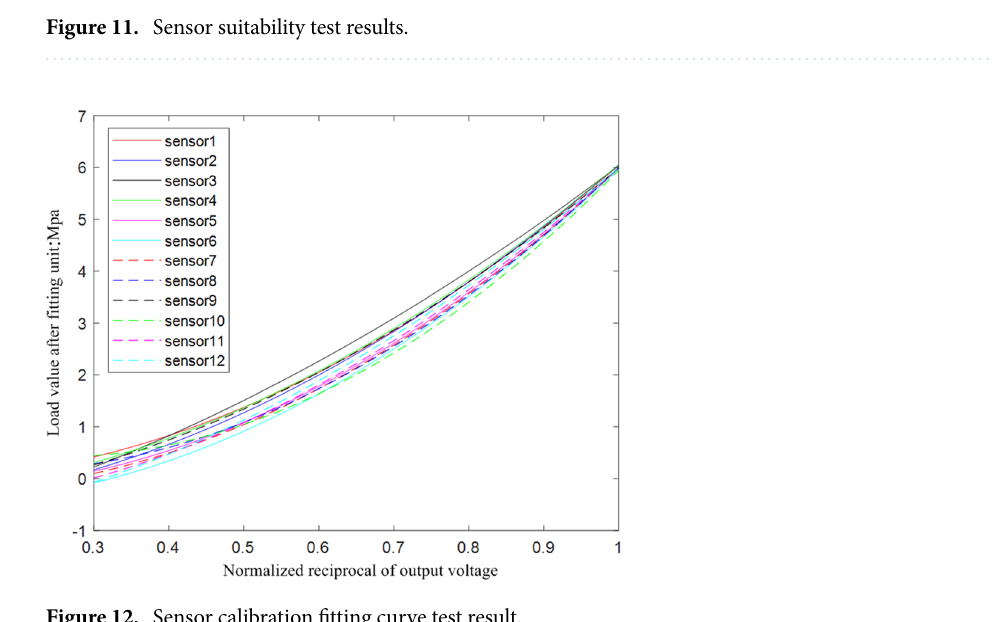
Figure 12. Sensor calibration fitting curve test result.